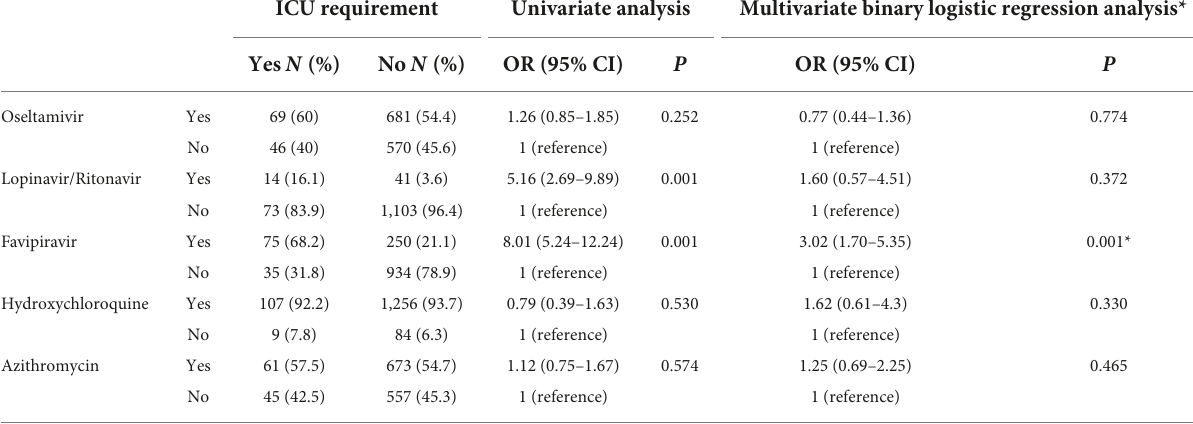
TABLE 3 The association of treatment drugs with the requirement of ICUs. ICU requirement Univariate analysis Multivariate binary logistic regression analysis*